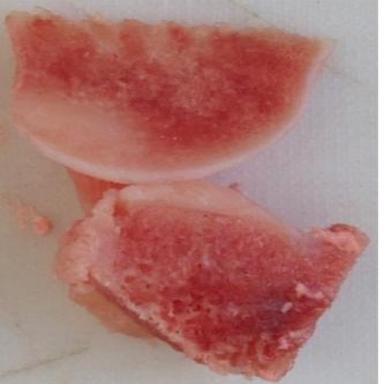
(a) Anterior and (b) posterior views of an anterior cruciate ligament. (c) The ligament with speckle patterns.